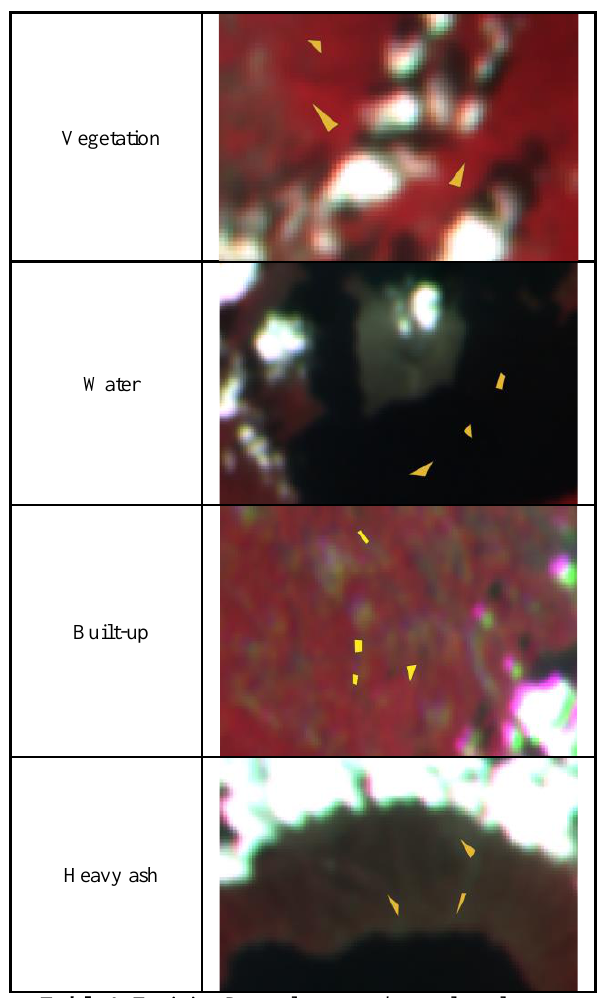
Table 1. Training Data classes and sample polygons The 2:30 pm color image of DIWATA-2 was used as the base layer in creating the polygons because it exhibits more clearly the vegetation, heavy ash, and cloud shadow on the land. The shapefile layer of the newly-created training polygons was used as the input for Training Areas for the Support Vector Machine classification in